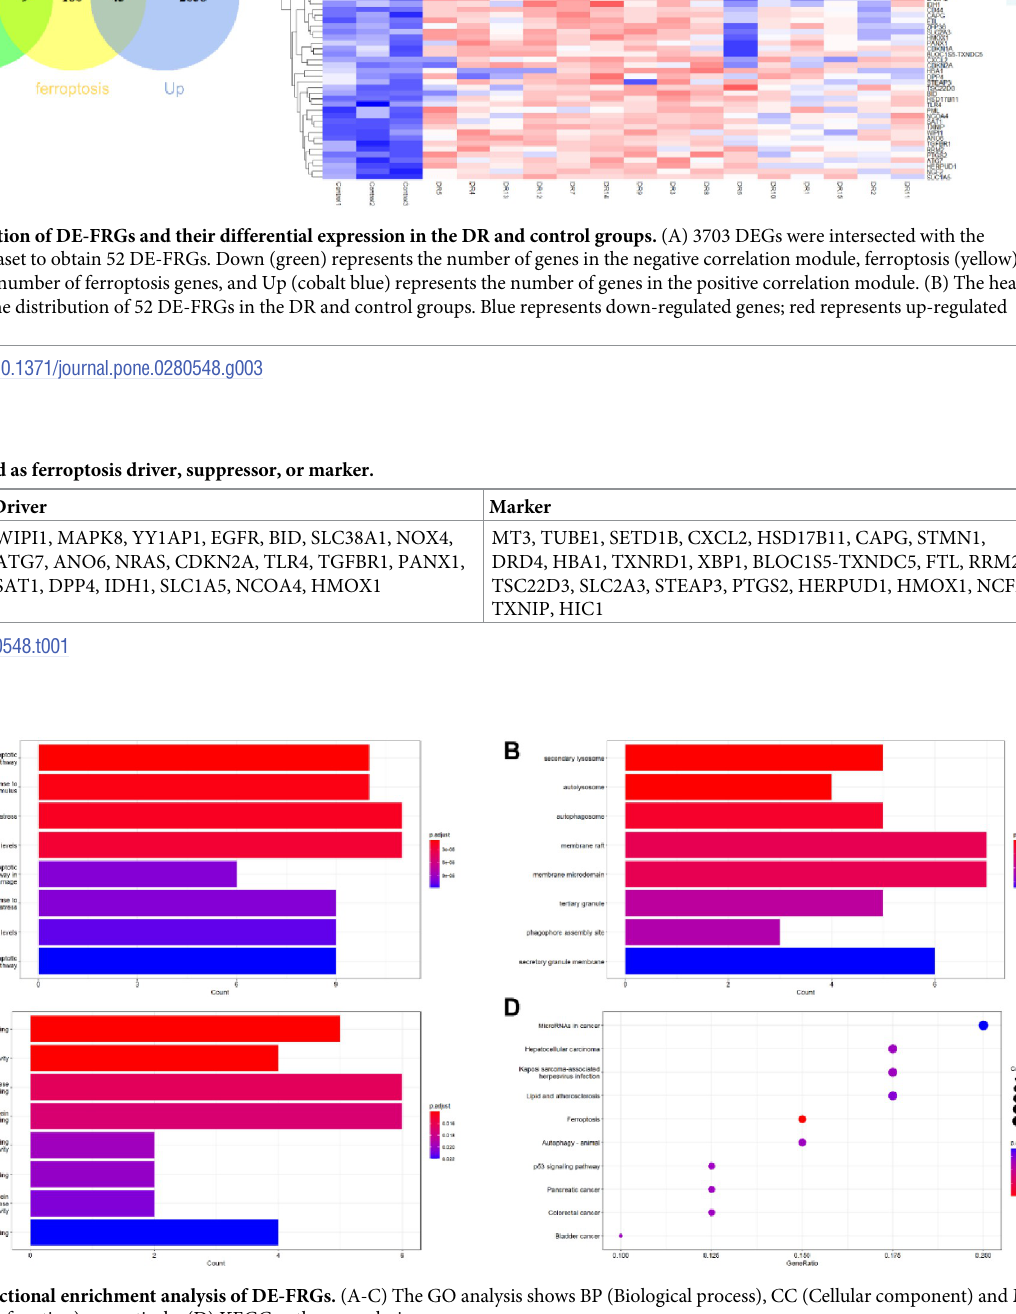
PLOS ONE | https://doi.org/10.1371/journal.pone.0280548 January 23,